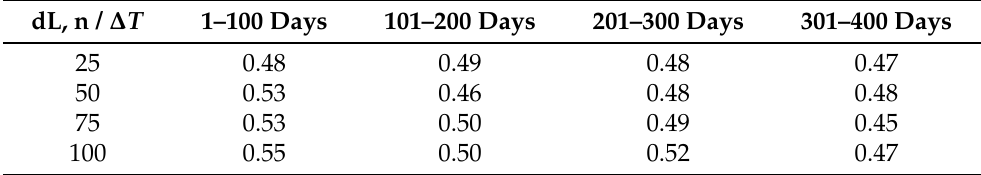
Figure 6. Example of a decision-making scheme with two trends Longer trends correspond to larger observation windows. Let us consider the result of using this method for four 100-day intervals with different levels of trend confirmation dL = 25 : 25 : 100. The corresponding data is presented in Table 6. It is easy to see that the modification did not have a positive effect. Table 6. Trend confirmation frequency for various time